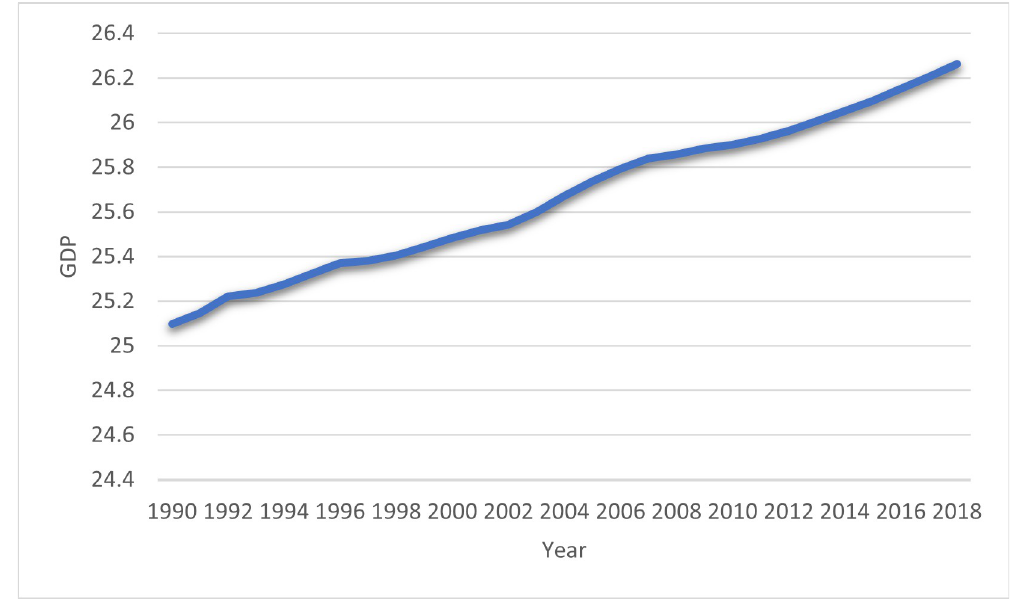
Fig 5. GDP in BRI economies: Source (World Development